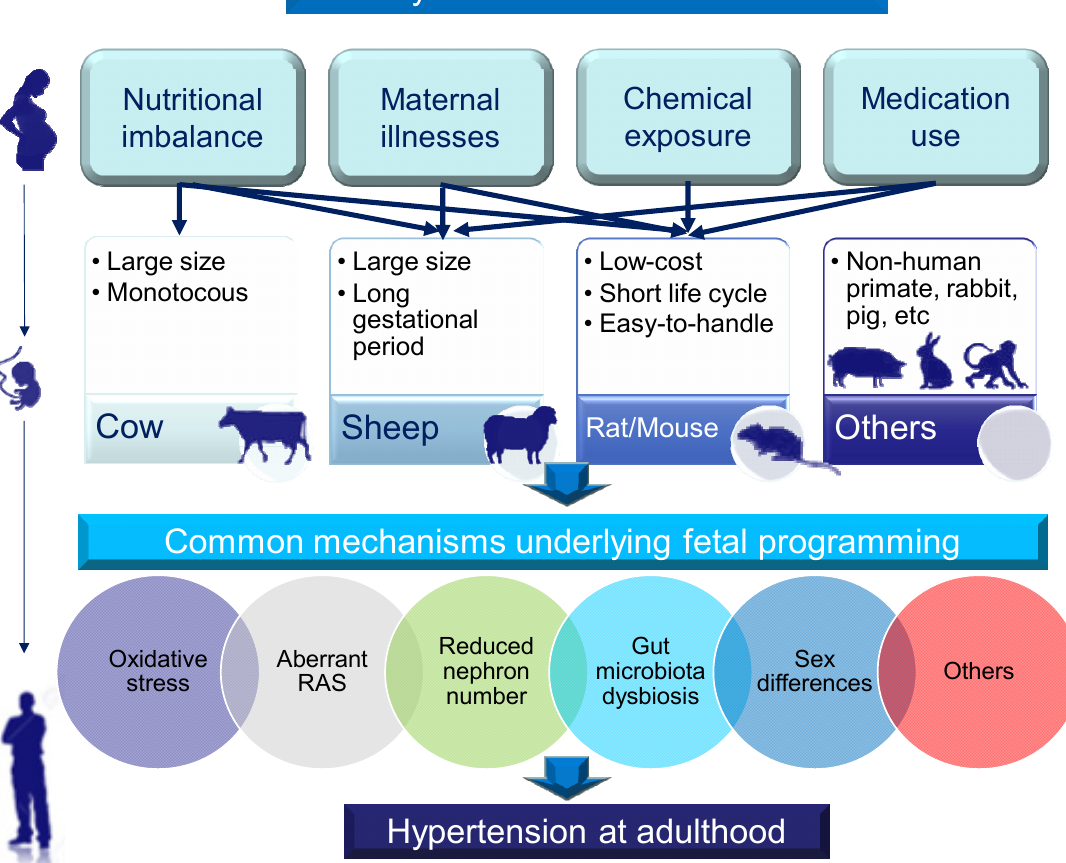
Figure 1. Schematic illustration of the selection of animal models for studying hypertension of developmental origins in adulthood according to early-life environmental insults, animal species, and common mechanisms. Lines with arrows (top section) indicate types of early-life insults produced in particular species of animals to induce hypertension in adult offspring. The study of other animals in DOHaD research (non-human primates, rabbits, pigs, etc.) is limited.